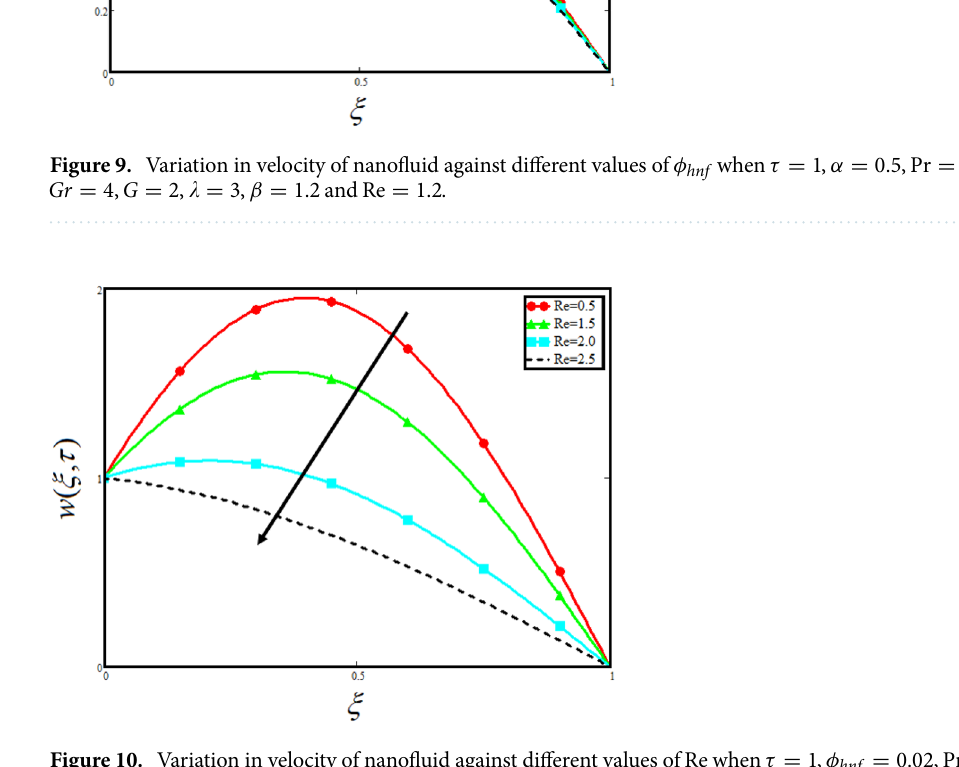
Figure 10. Variation in velocity of nanofluid against different values of Re when τ = 1 , φ hnf = 0.02 , Pr = 21 , Gr = 4 , G = 2 , (cid:31) = 3 , β = 1.2 and α = 0.5